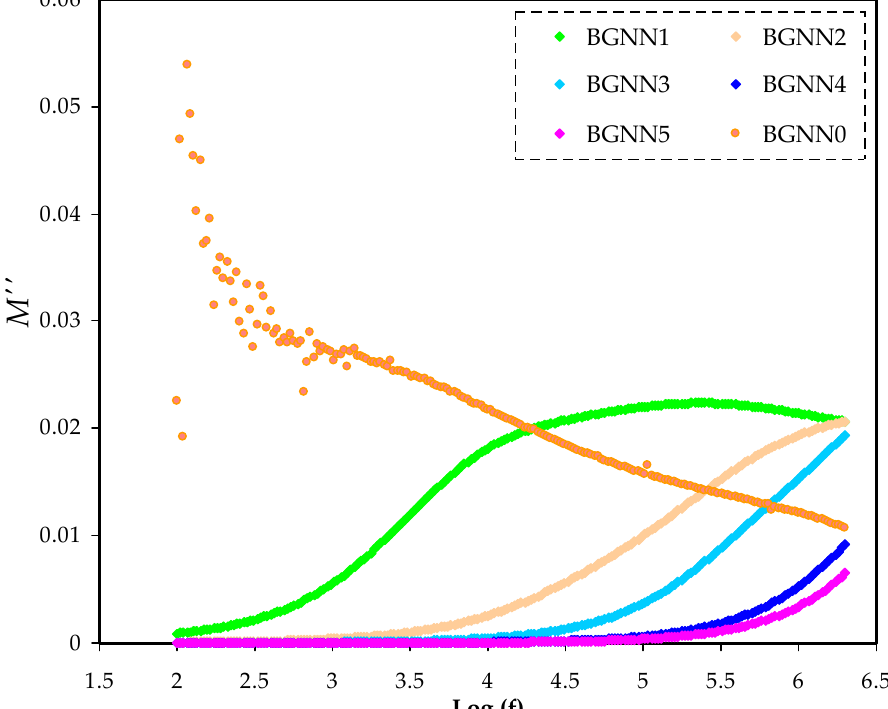
Figure 8. The M” spectra for the NBG electrolyte systems.